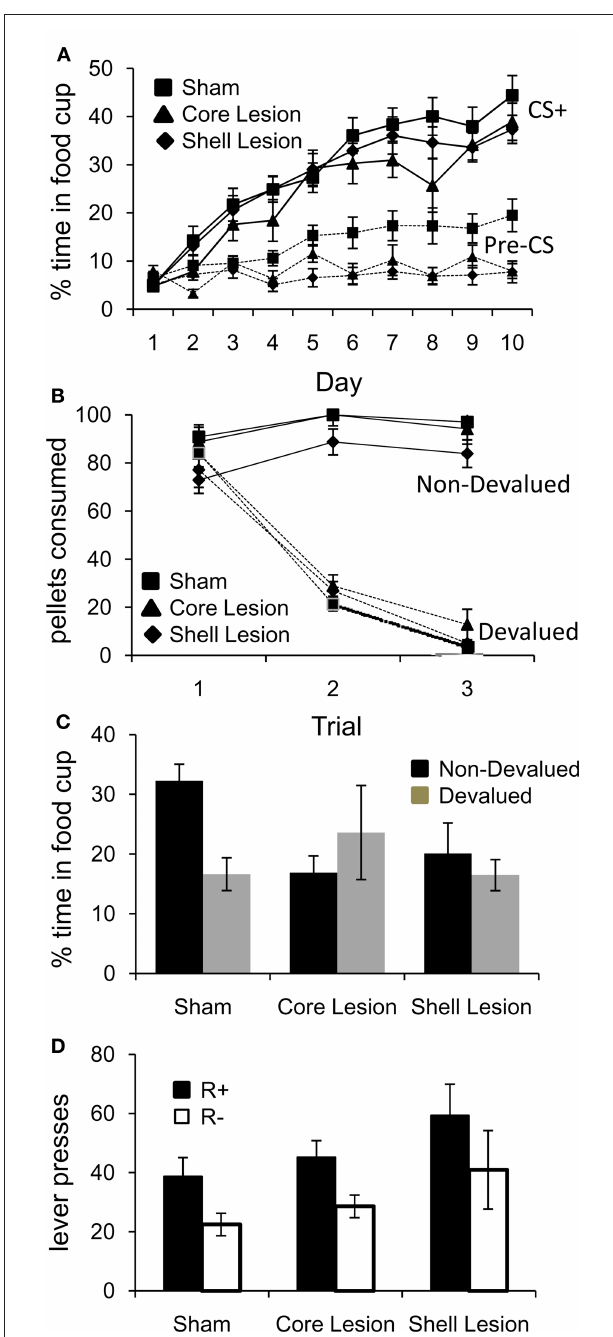
FIGuRe 2 | effect of NA core and shell lesions on Pavlovian conditioning (A), reinforcer devaluation (B), conditioned responding after devaluation (C), and conditioned reinforcement (D). Bars indicate SEMs; * p <